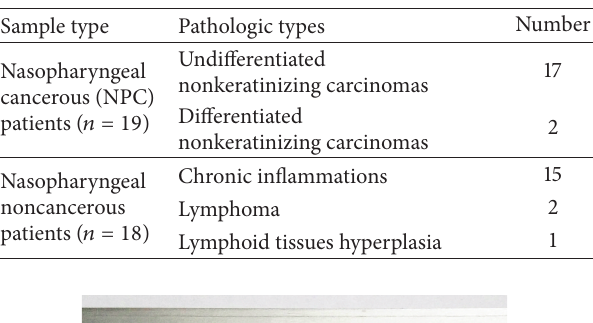
Table 1: Sample characteristic.